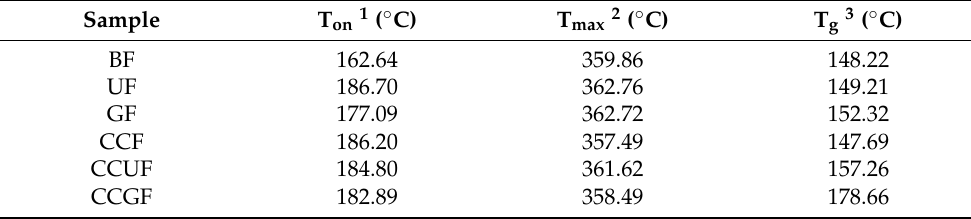
Table 5. Thermal properties of the regenerated cellulose fibers after different stage of treatment.